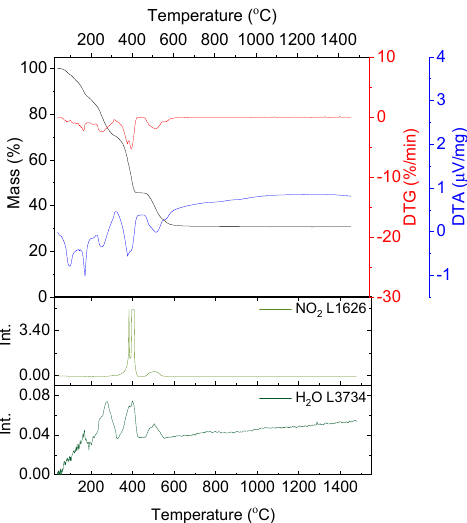
Figure 1. Thermal analysis results of the decomposition of yttrium nitrate hexahydrate in argon flow; absorbance intensities of traces for wavenumbers: 1626 and 3734 cm − 1 corresponding with absorbance peaks of NO 2 and H 2 O, respectively.